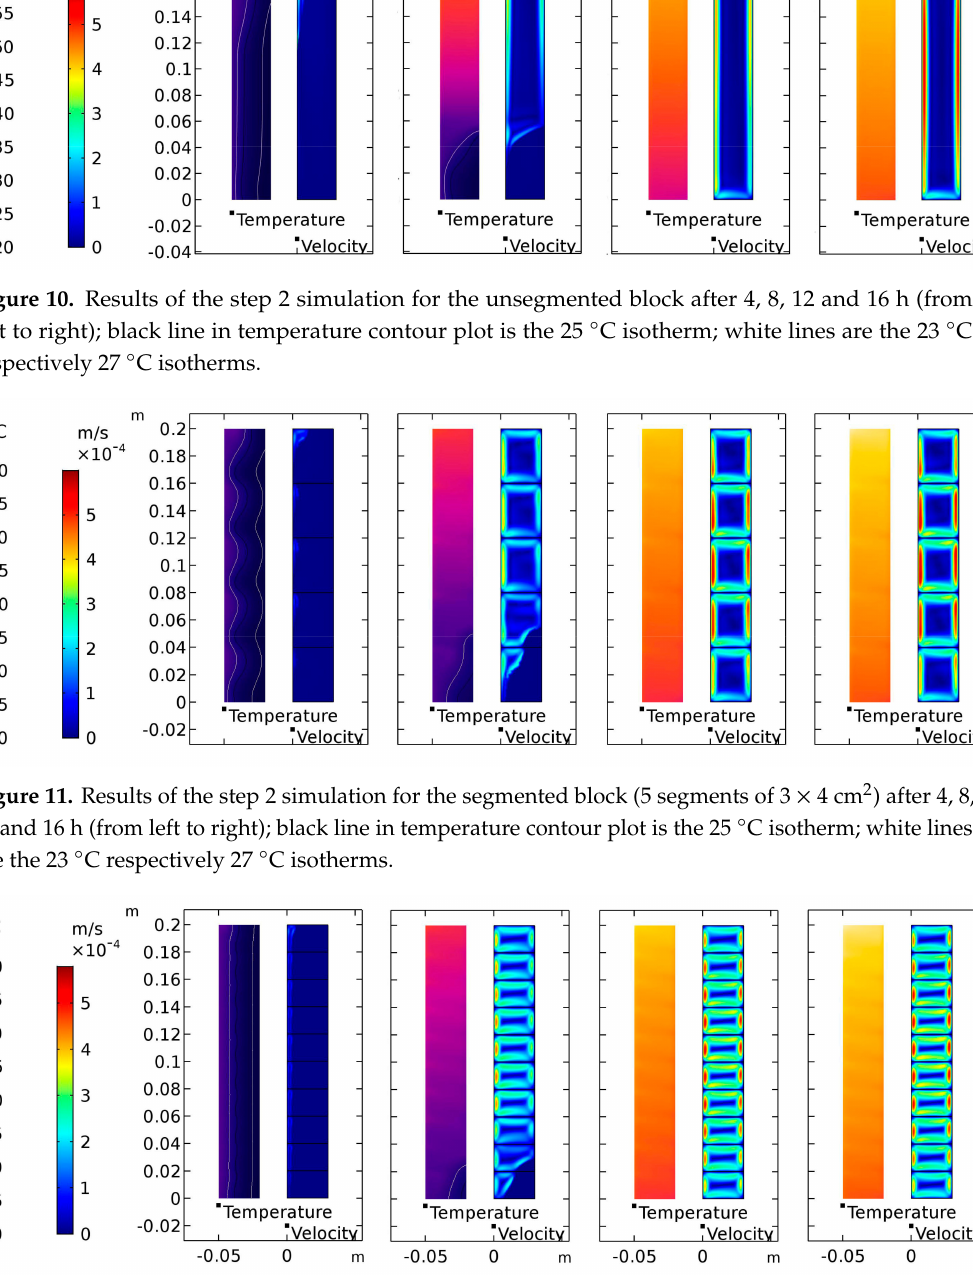
Figure 12. Results of the step 2 simulation for the segmented block (10 segments of 3 × 2 cm 2 ) after 4, 8, 12 and 16 h (from left to right); black line in temperature contour plot is the 25 ◦ C isotherm; white lines are the 23 ◦ C respectively 27 ◦ C isotherms. Table 3. Minimum (bottom), maximum (top) and average temperatures of the PCM after 8